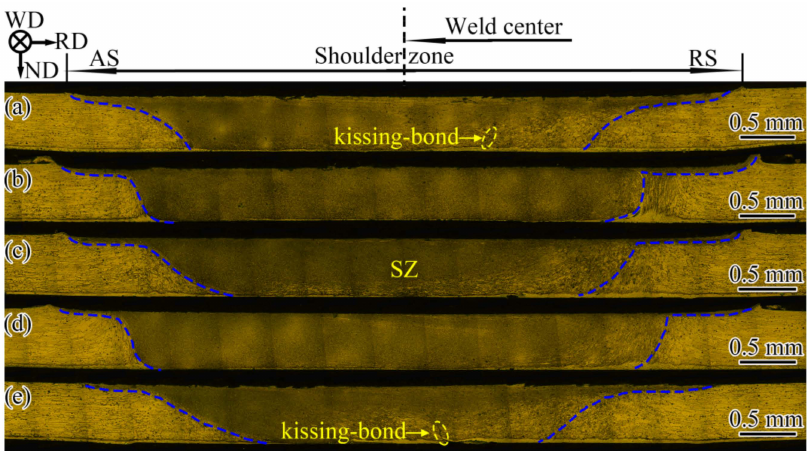
Figure 7. Transverse cross sections of the joints produced using parameters of ( a ) 3000-600-P-Fe, ( b ) 6000-600-P-Fe, ( c ) 6000-1200-P-Fe, ( d ) 6000-600-PL-Fe, and ( e )